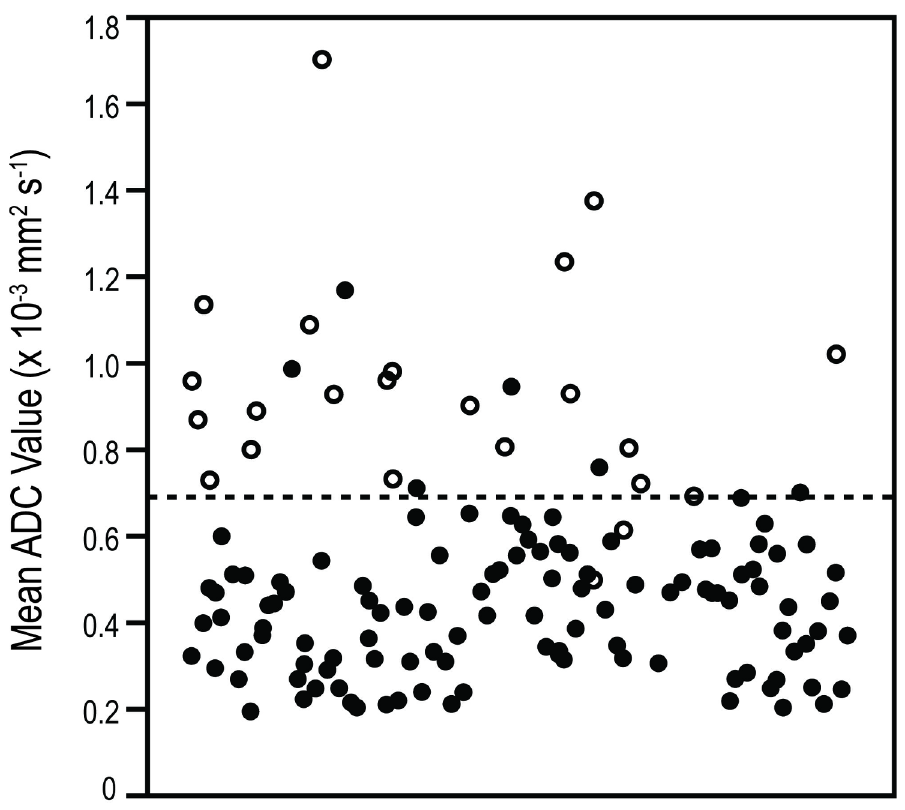
Fig 3. Distribution of apparent diffusion coefficient (ADC) values in benign and malignant lesions in a) whole lesion and b) small regions of interest (ROIs). ADC values (× 10 − 3 mm 2 s- 1 ) of individual lesions are presented on the Y-axis. Black dots represent malignant lesions, and empty circles represent benign lesions. The line indicates the used cut-off values, 0.87 × 10 − 3 mm 2 s -1 for whole lesion ROIs and 0.69 × 10 − 3 mm 2 s -1 for small